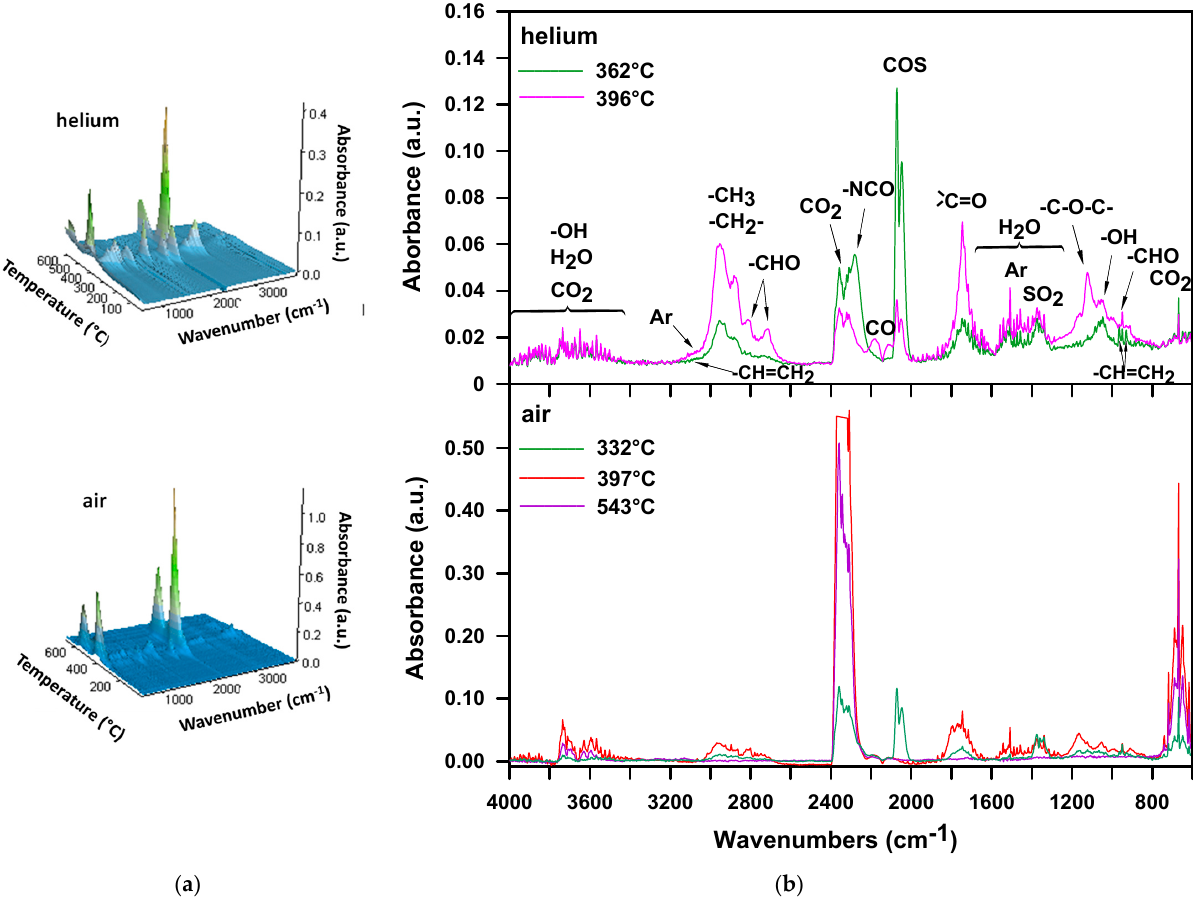
Figure 10. FTIR spectra of volatile products evolved during thermal decomposition of H-50: ( a ) 3D and ( b ) extracted at the maxima of decomposition.